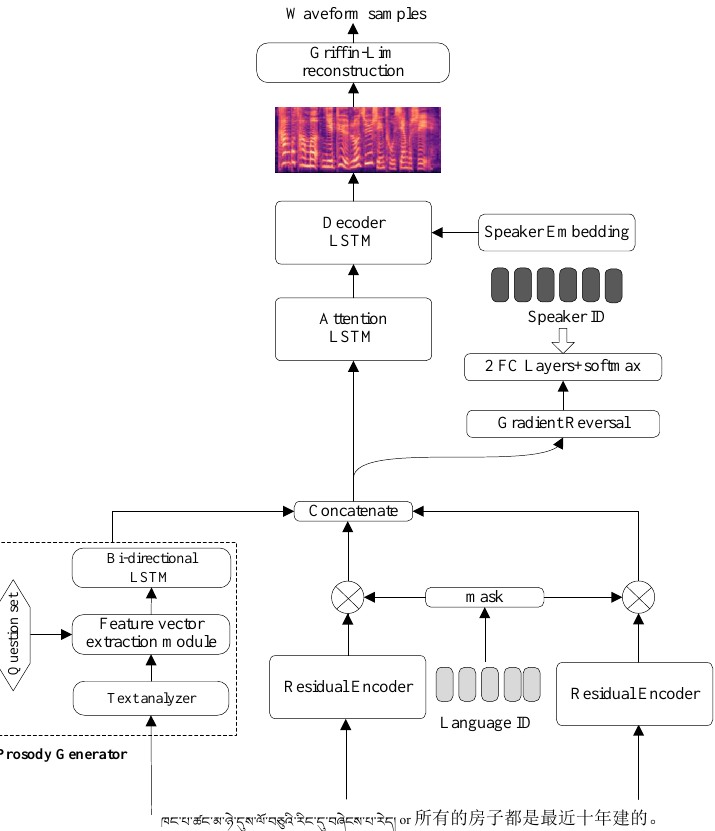
Figure 3. The separate encoder Mandarin-Tibetan TTS. We use separate residual encoders for each language to handle phoneme sequences from different languages with explicit language embedding. In the figure, the input is a Tibetan sentence (left) or a Chinese sentence (right), which means that all houses have been built in the last ten